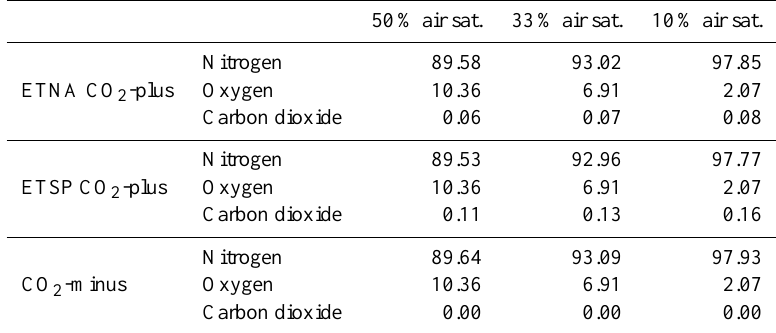
Table 1. Volumetric composition of used premixed gases.